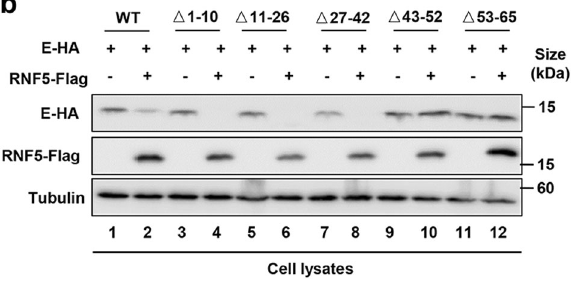
Fig. 6b Sensitivity of E mutants to RNF5-mediated degradation.